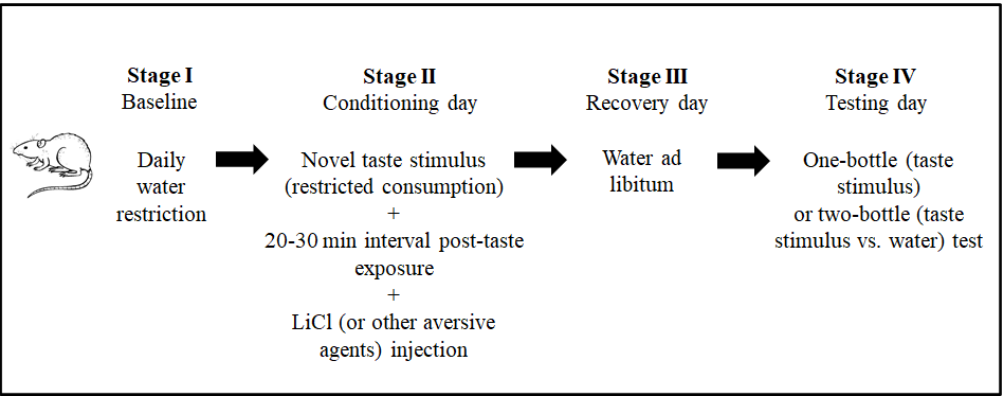
Figure 2. Principal stages of the procedure to induce conditioned taste aversion (CTA) in laboratory animal models.